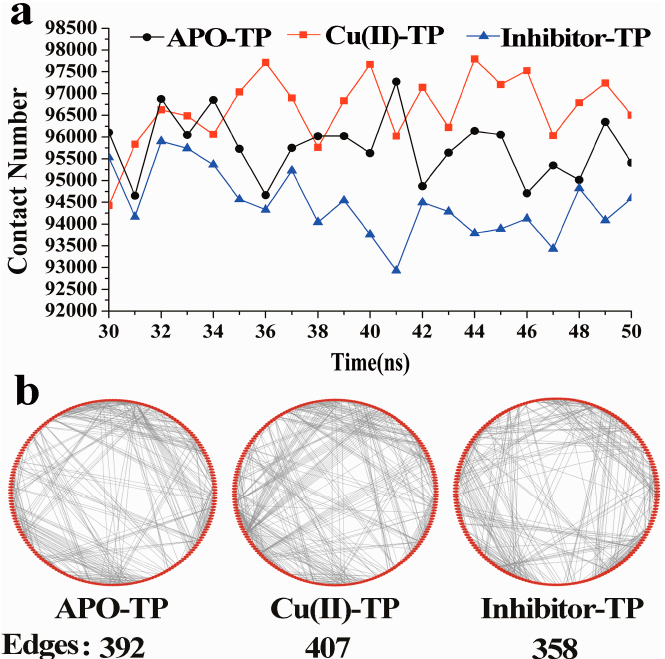
Figure 4. The contacts and residue ‐ residue network of three systems. ( a ) The number of the contacts in trypsin as a function of time during the simulations for APO ‐ TP model (black), Cu(II) ‐ TP model and inhibitor ‐ TP model (blue); ( b ) Residue ‐ residue network of three systems. Residues are represented as red dots evenly distributed around the circle, while interactions between residues including hydrogen ‐ bond interactions, van der Waals force, ionization and π‐π stack are defined as edges represented by grey lines.